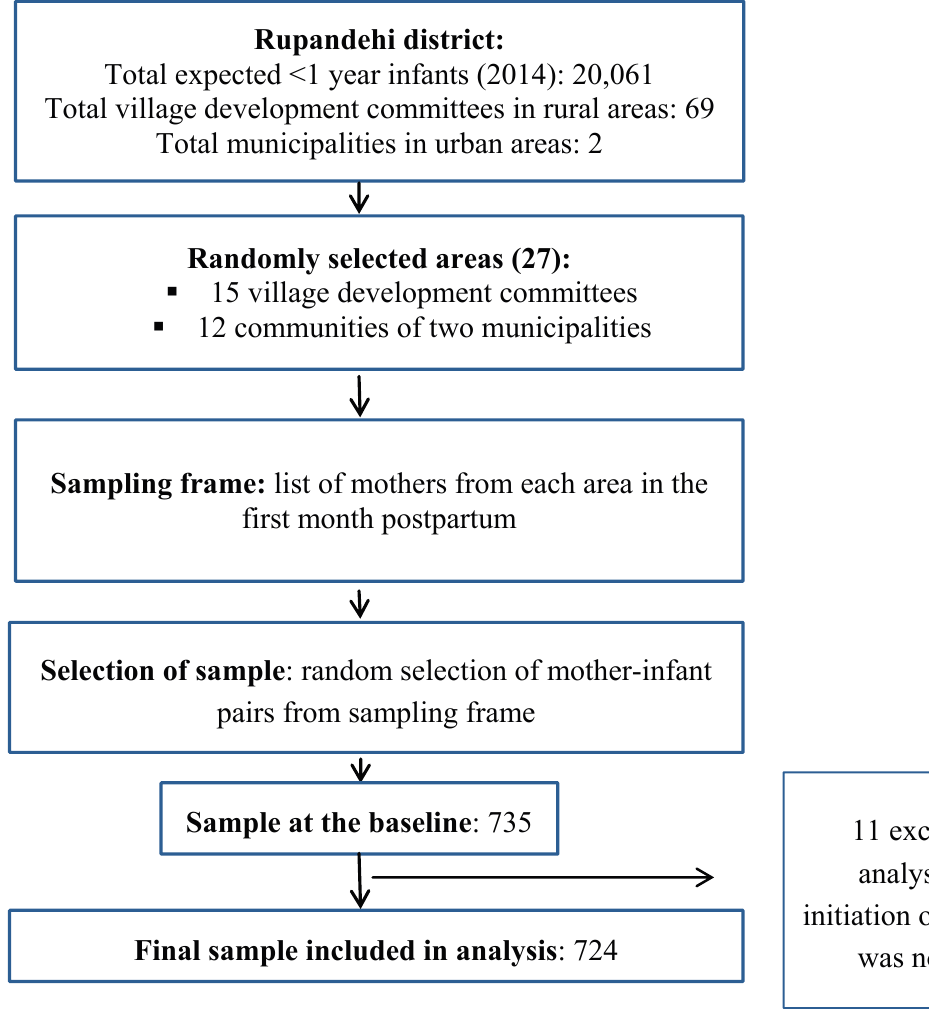
Figure 1. Study flow